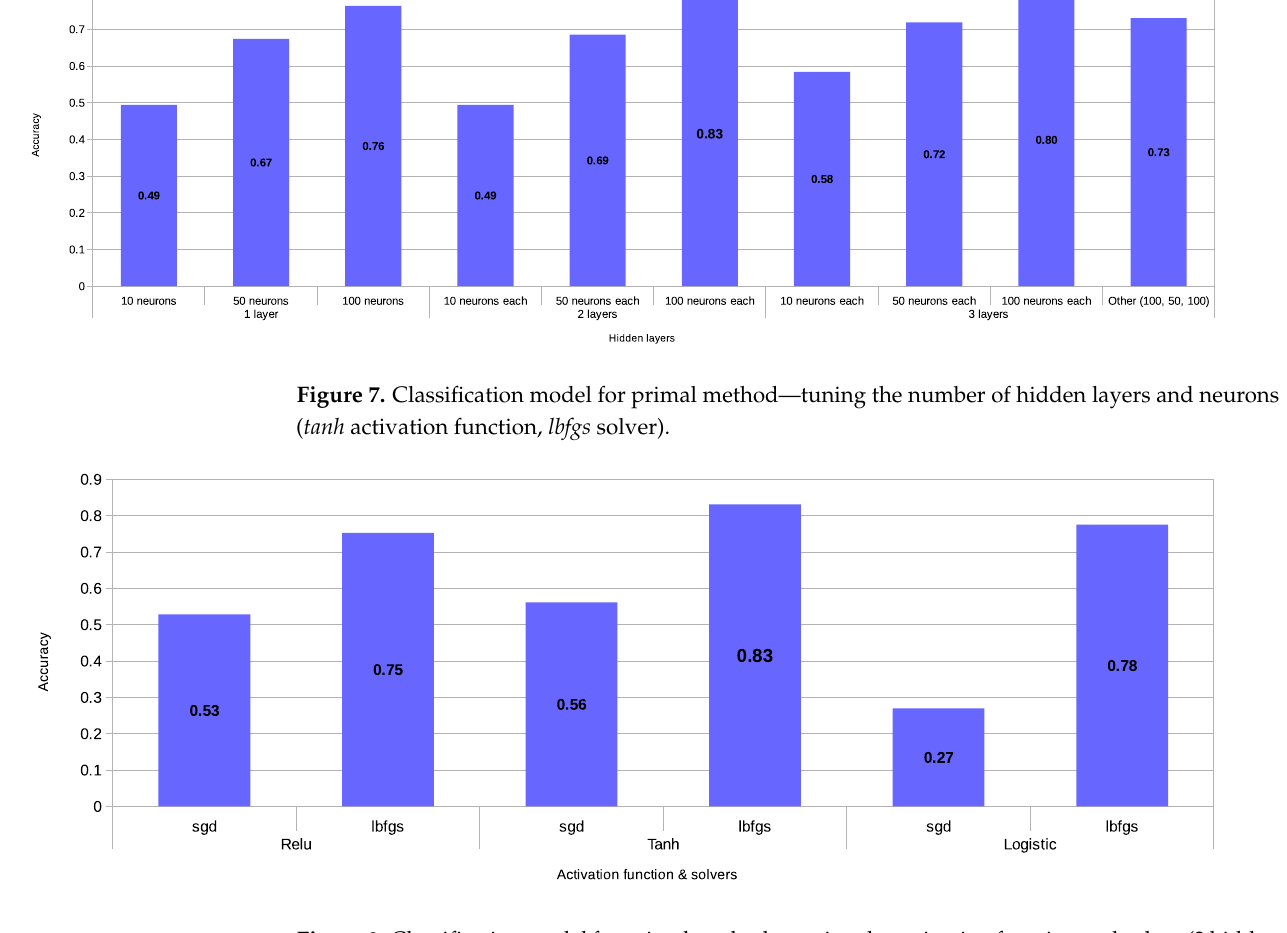
Figure 8. Classification model for primal method—tuning the activation function and solver (2 hidden layers, 100 neurons each).